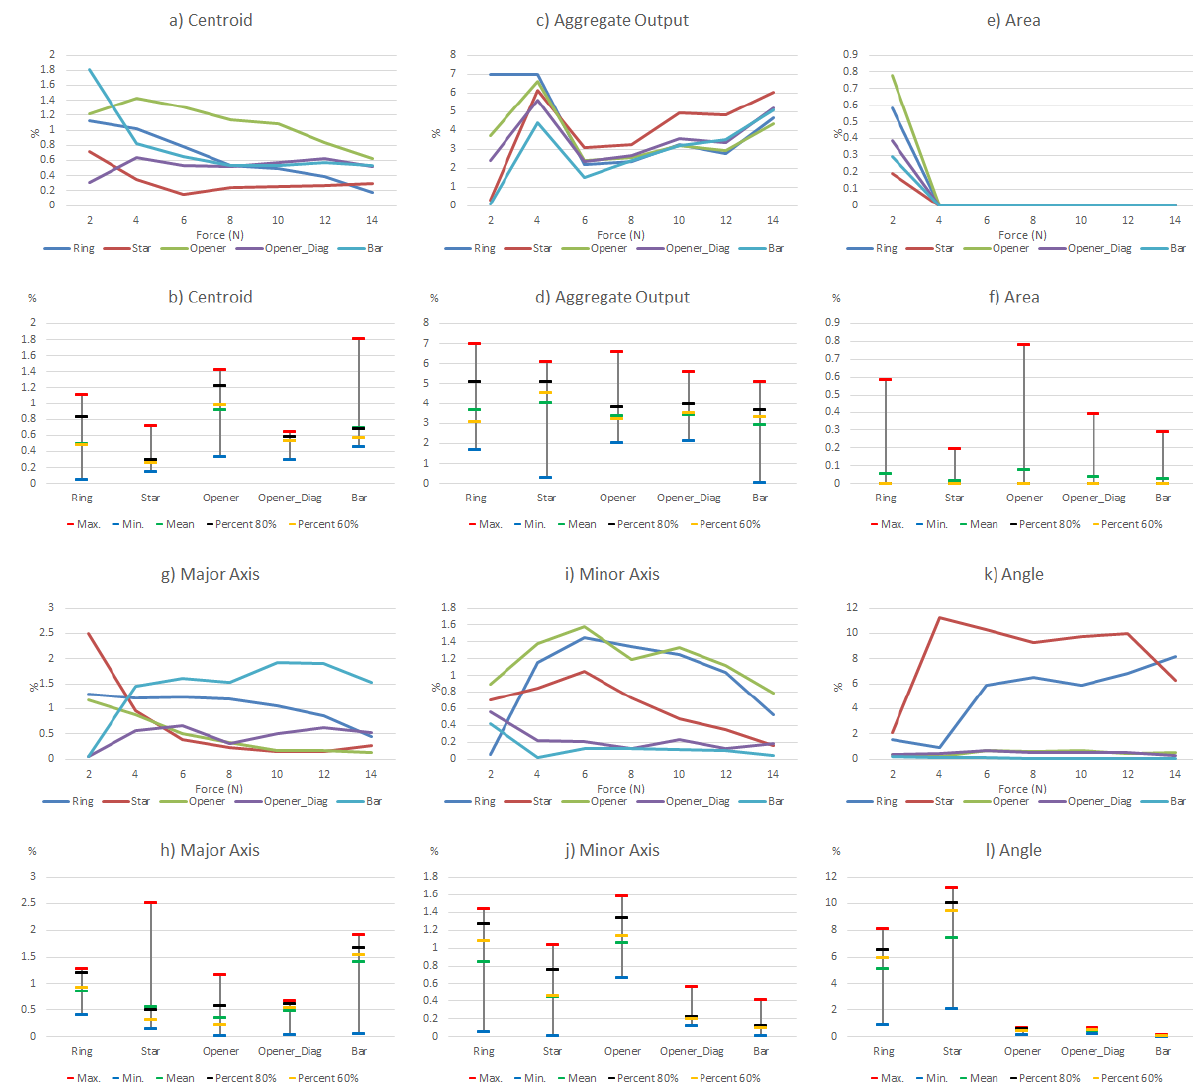
Figure 11. Variations of the system level parameters caused by the commercial sensor